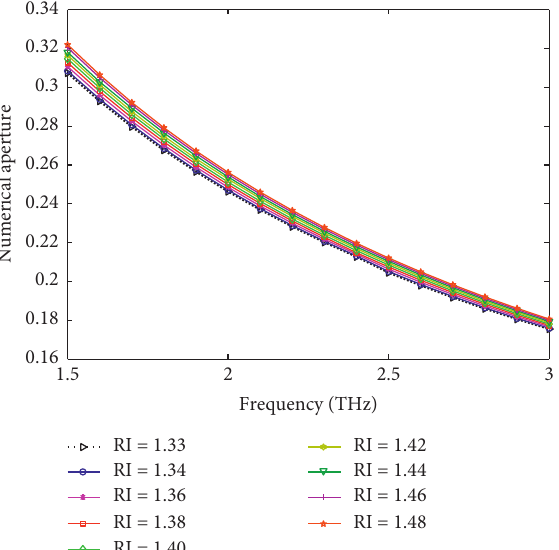
RI = 1.33 RI = 1.34